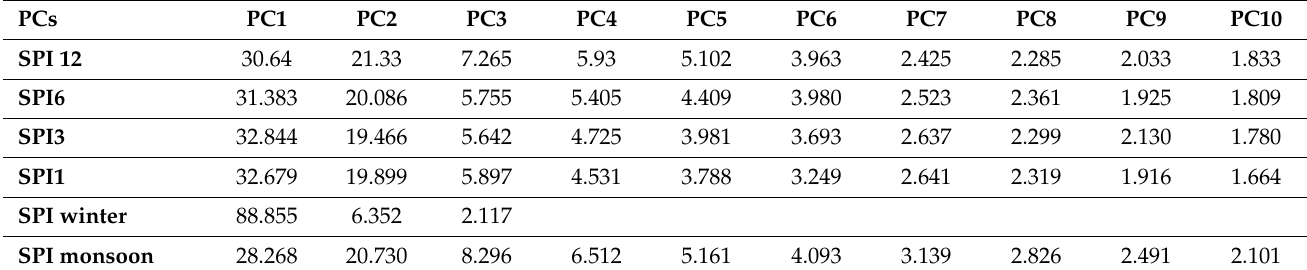
Table 2. Percentage of variance explained by loadings without rotation.